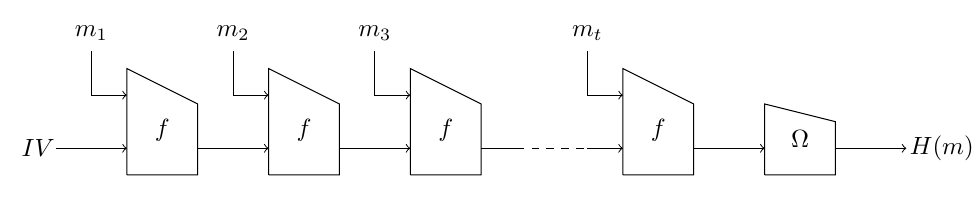
Figure 1: The Grøstl-512 hash function.